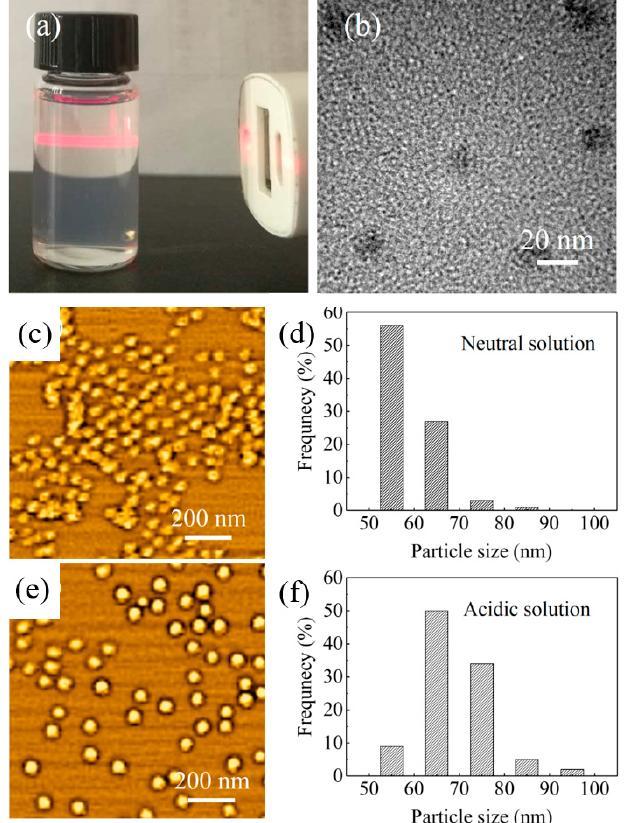
Figure 1. ( a ) Photograph of the reaction solution after micellization, a light scattering of the Tyndall effect demonstrates the presence of micelles. ( b ) TEM image of micelles. AFM images and particle size distribution histograms of micelles ( c,d ) in neutral solution and ( e,f ) in acidic solution. The particle size distribution histograms were obtained from representative regions, and the diameters of 100 micelles were collected.